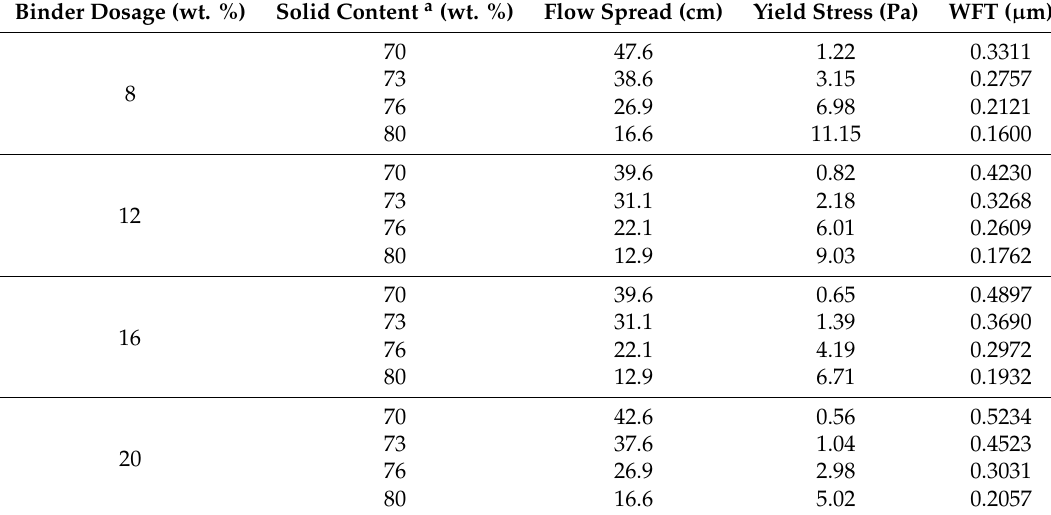
Table 5. Flowability of the CPB slurry.